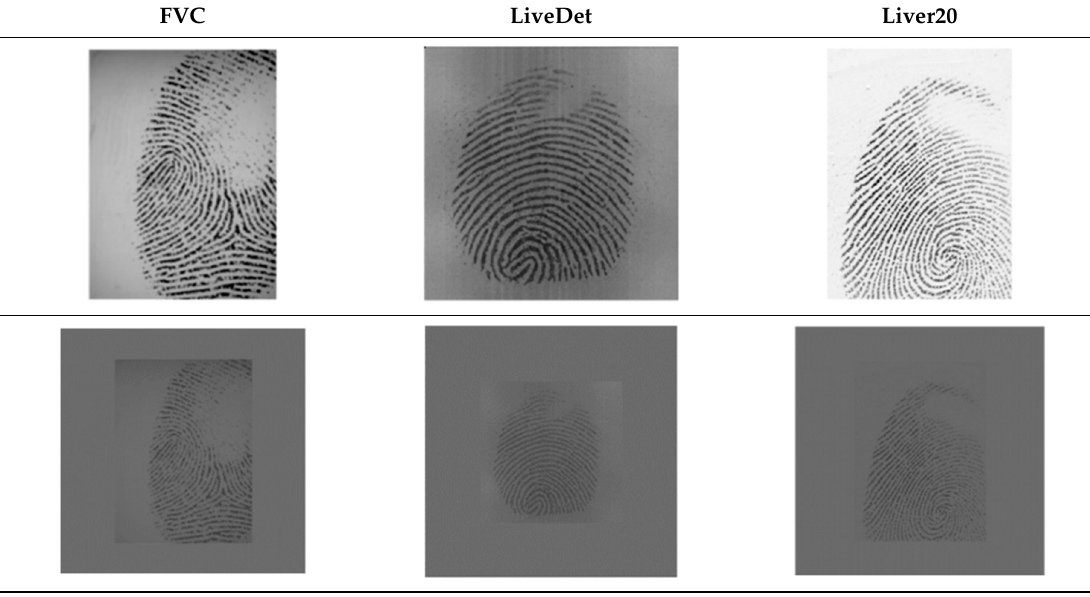
Table 1. Original fingerprint image and normalized image from three datasets.